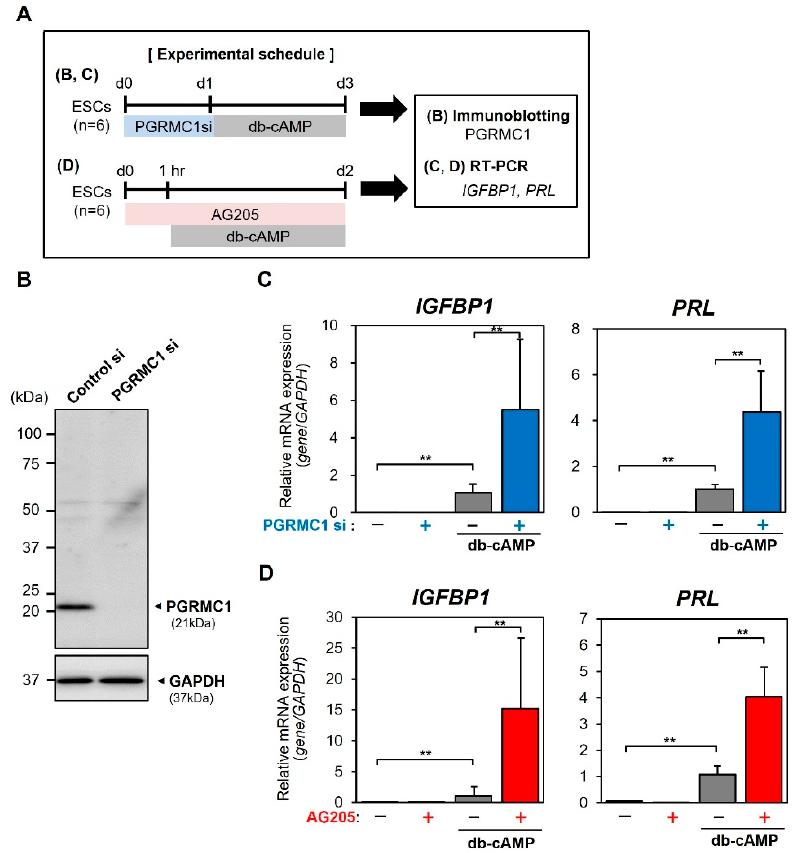
Figure 4. Effects of PGRMC1 knockdown and inhibition on db-cAMP-induced decidualization. ( A ) Experimental schedules. ( B , C ) ESCs transfected with control or PGRMC1-specific siRNA were stimulated with db-cAMP for 2 days. ( B ) Immunoblot analysis of PGRMC1 expression. ( D ) Cells were treated with AG-205 and then stimulated with db-cAMP for 2 days. ( C , D ) Total RNA was subjected to real-time RT-PCR analysis to determine the expression levels of IGFBP1 and PRL . GAPDH served as an internal control. Data represent the mean ± SEM of three independent experiments. ** p < 0.01.